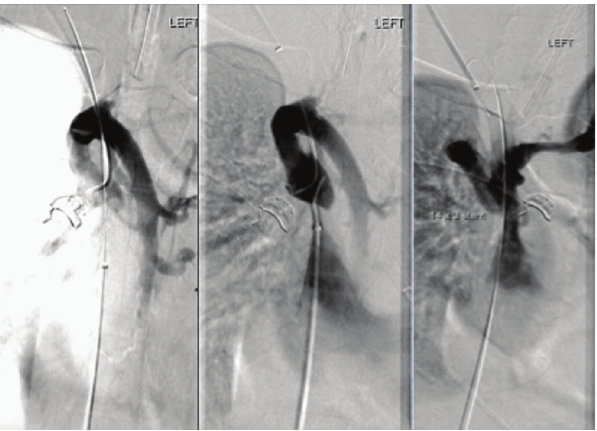
Figure 3: SVC venogram showing recannulization and stenting of distal occluded